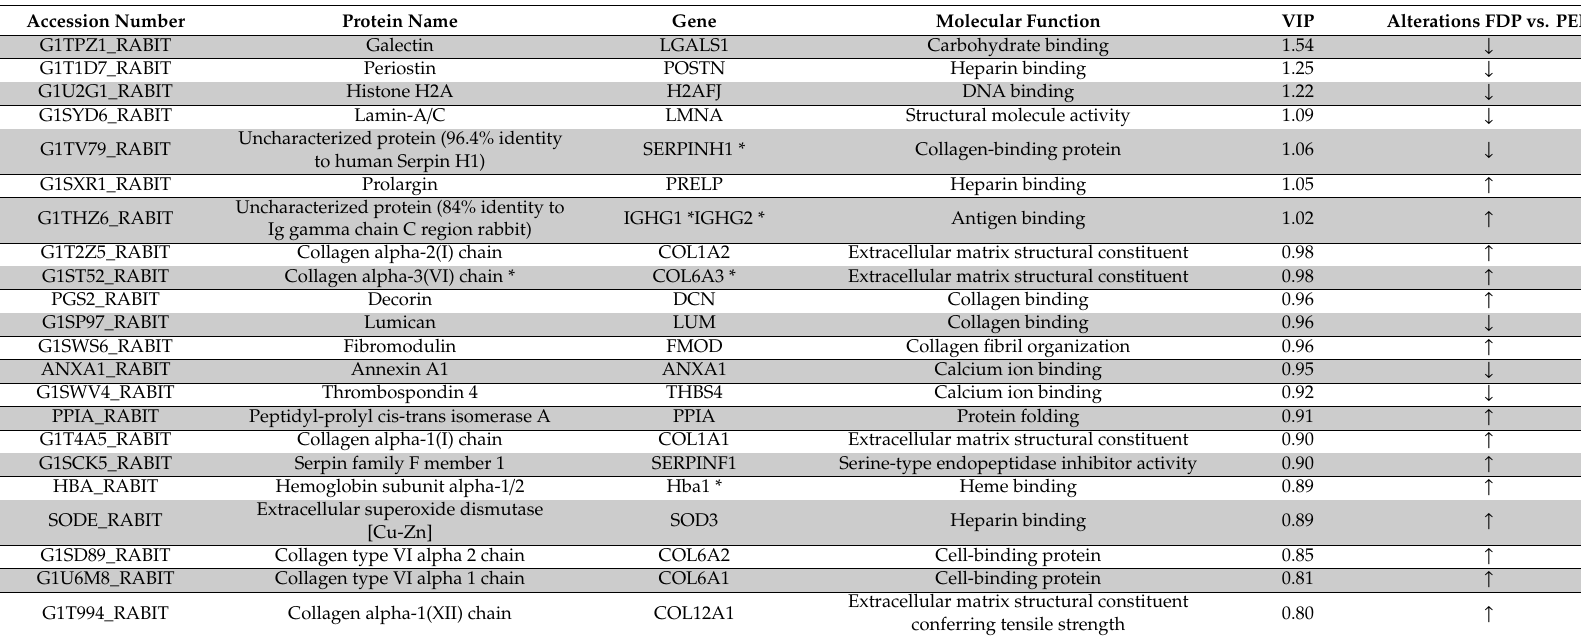
Table 1. Altered proteins in intra synovial Flexor digitorium profundus (FDP) and extra synovial Peroneus tendon (PER) tendon grafts. ↑ = Upregulated; ↓ = Downregulated in FDP compared to PER. The accession number and molecular function are based on the UniProt database (http: // web.expasy.org). * refers to human ortholog. Proteins with VIP (variable influence of projection) value > 1 are considered to be important / significant for separation between FDP and